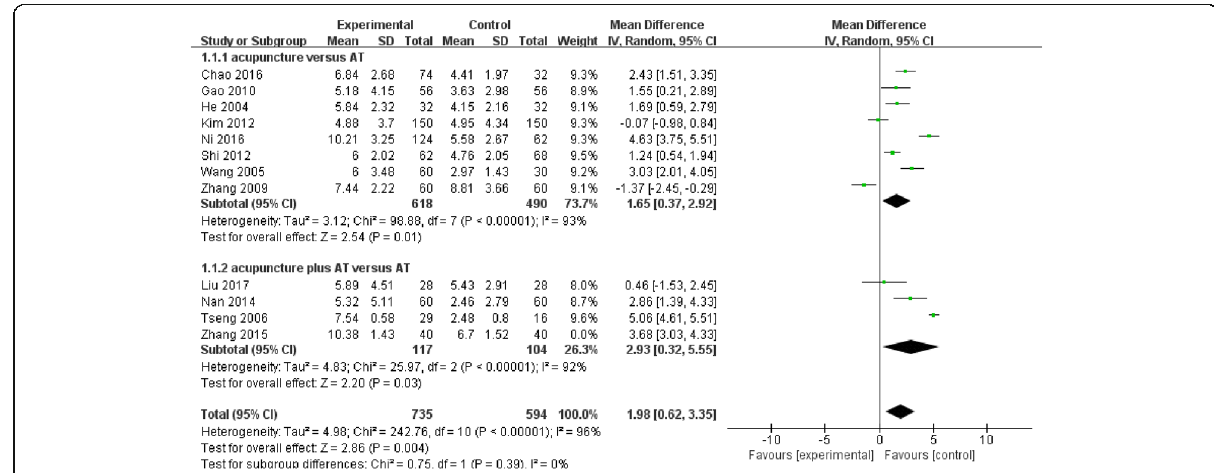
Fig. 4 Schirmer ’ s test (ST) comparison between acupuncture and artificial tears (AT): Random effect